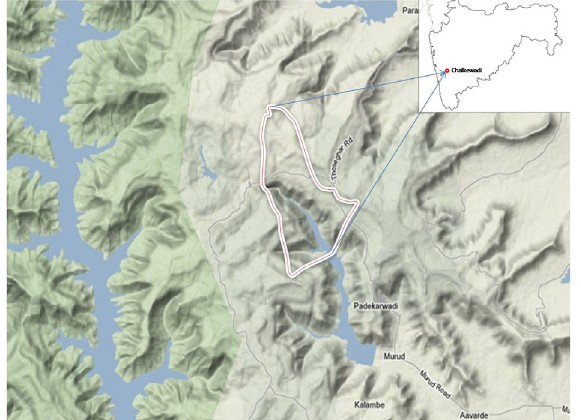
ventralFigure 3. Epigyne